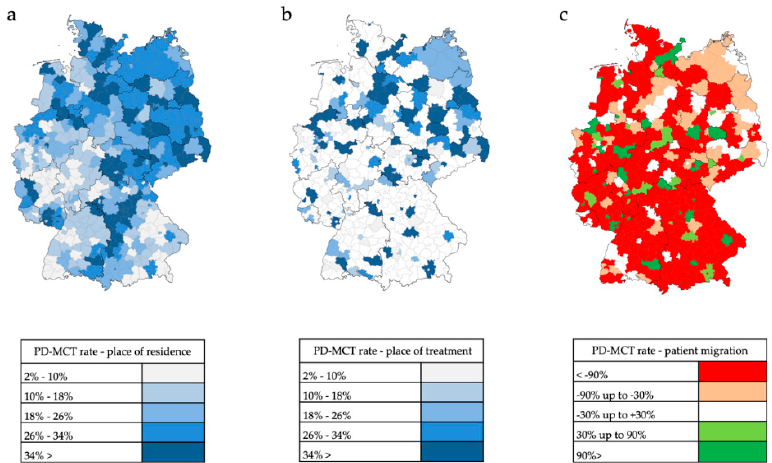
Figure 7. Inpatient PD-MCT in 401 administrative counties in Germany in the year 2016. ( a ) Ratio of PD-MCT to PD inpatients based on patients’ place of residence. ( b ) Ratio of PD-MCT to PD inpatients based on patients’ place of treatment. ( c ) Patient migration rate (G20+G21+G23) calculated as relative difference between patients’ place of residence and patients’ place of treatment of PD-MCT number. Values near to 0% indicate a balanced migration ratio. Values less than − 30% indicate a distinct out-migration while values greater than +30% indicate a distinct immigration.